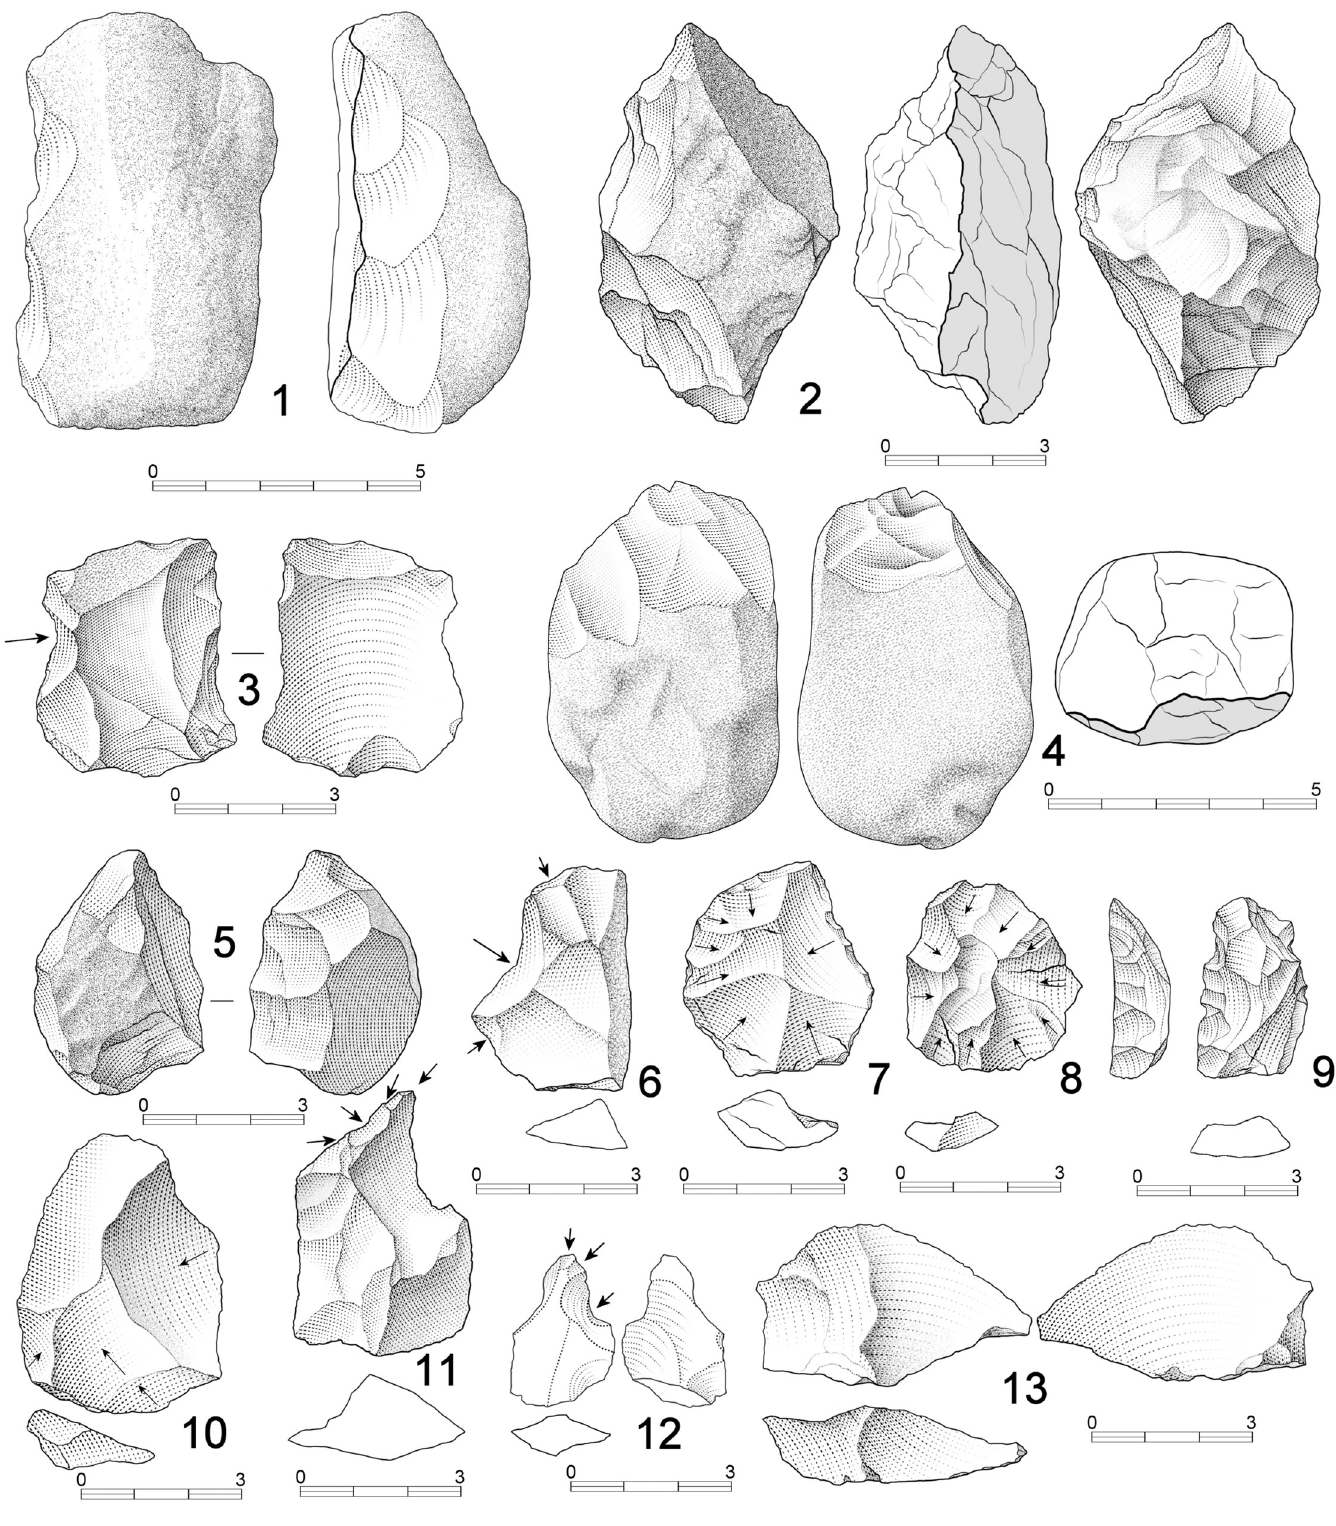
Fig 6. Lithic artefacts from DS. 1. Chopper on basalt showing a lateral, abrupt and continuous series of short removals (74x52x 39 mm); 2. Chopper on basalt showing lateral, bifacial and continuous short removals (71x48x34 mm); 3. Retouched phonolite flake showing a notch on the left side and discontinuous, deep retouch on the